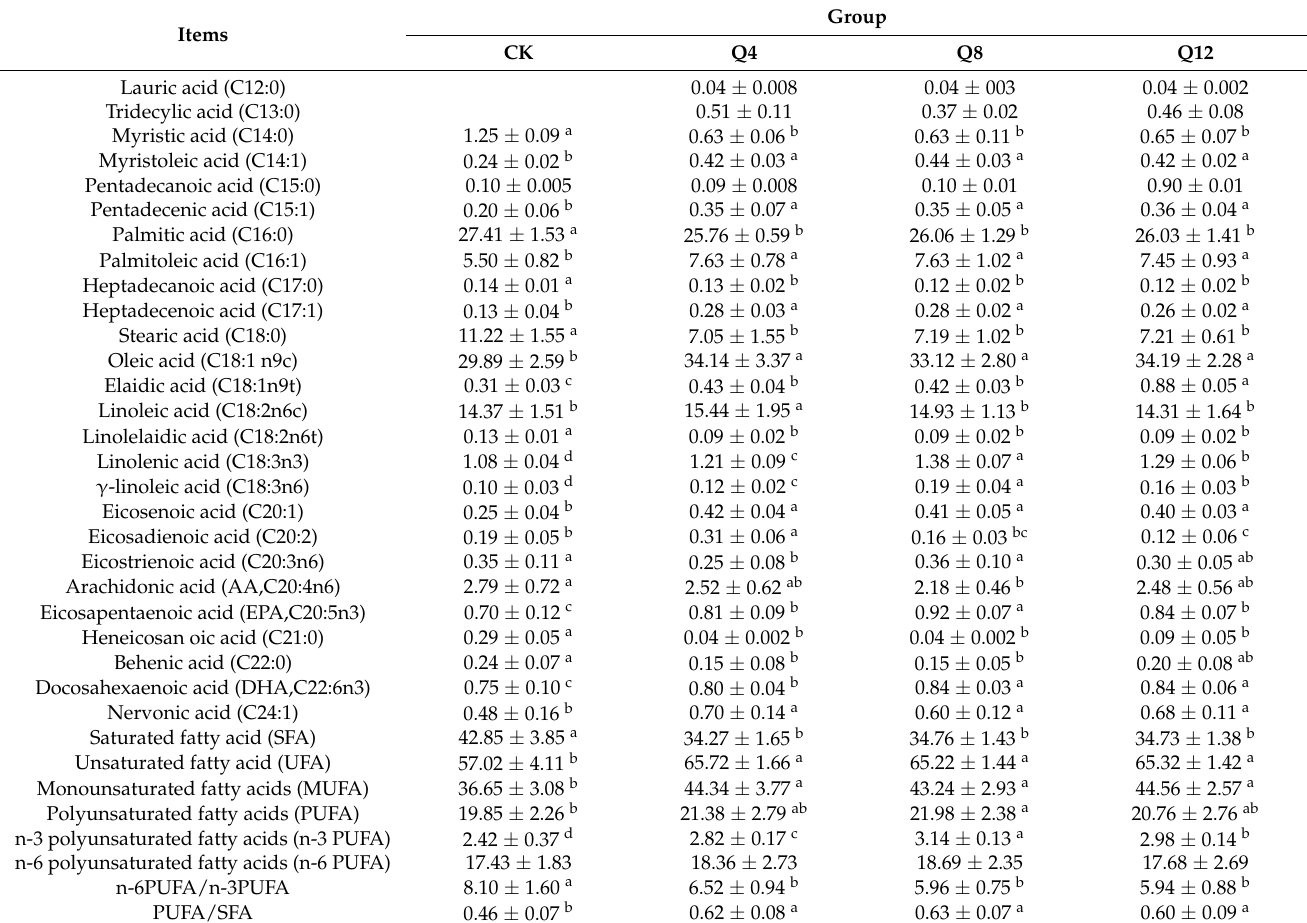
Table 3. Effect of quinoa on fatty acid composition and content in leg muscle of female Luhua chicken %.